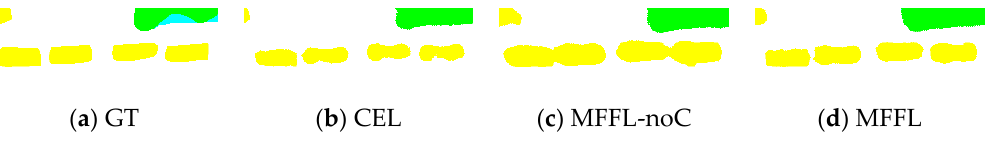
Figure 4. Results of an image patch with cars obtained from DPN, trained by different loss functions. Classes: Impervious Surface (white); low vegetation (cyan); tree (green); and car (yellow). GT: ground truth; CEL: result obtained from DPN trained by standard cross entropy loss; MFFL-noC: result obtained from DPN trained by median frequency balanced focal loss without constraint; MFFL: result obtained from DPN trained by median frequency balanced focal loss.